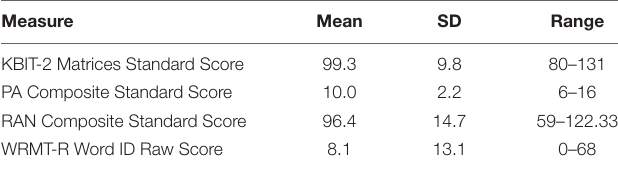
TABLE 1 | Scores on behavioral measures for the full sample. Measure Mean